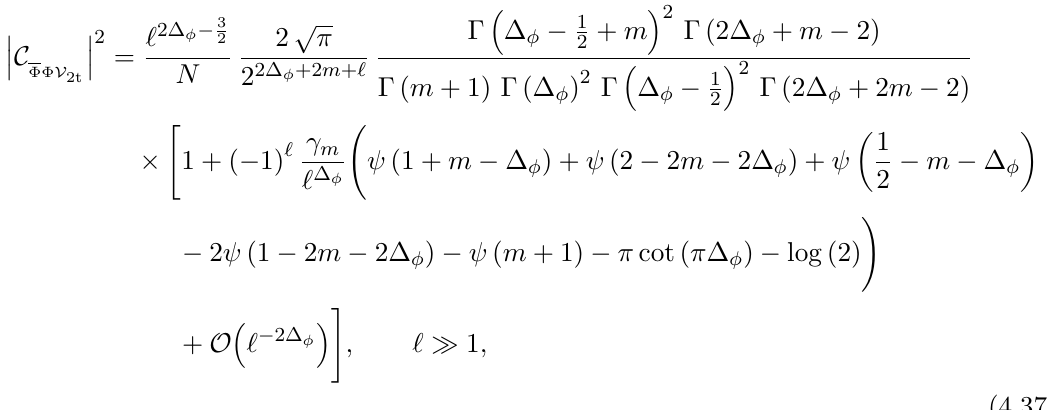
Figure 5 . A plot of the product of OPE coefficients the convergence to the asymptotic behaviour − 4 log 2 m − 11 by the solid